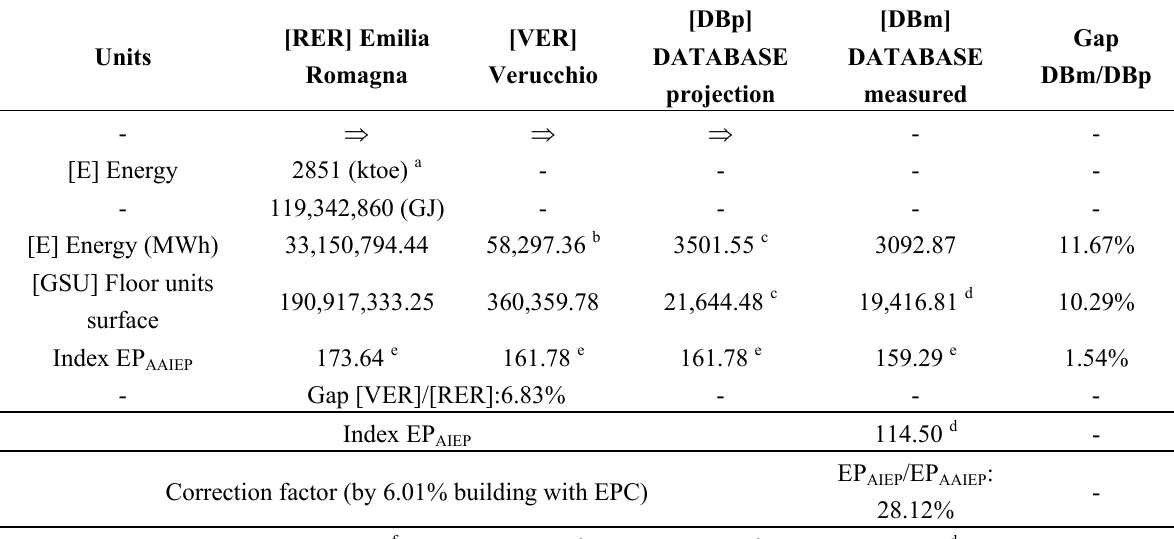
Table 6. Top-down to bottom-up